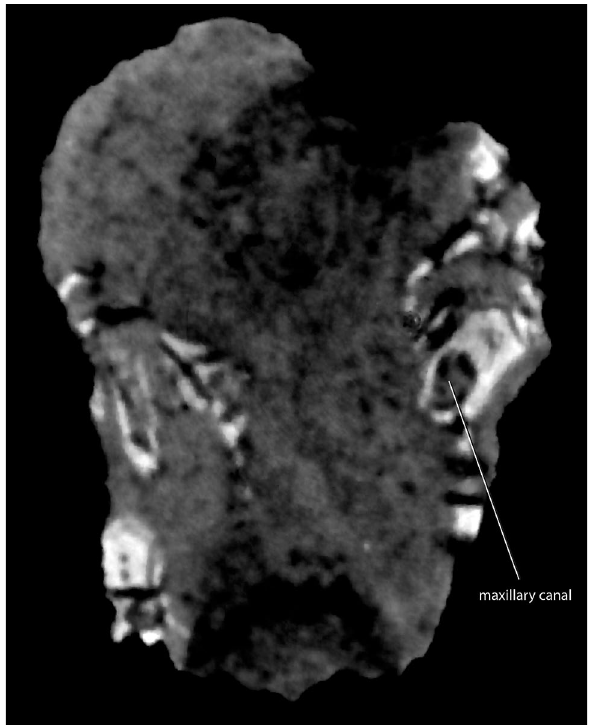
Figure 3. The holotype of Tessellatia bonapartei , gen. et sp. nov. (PULR-V121). Neutron tomography image of a transversal cross-section of the cranium showing the ossified maxillary